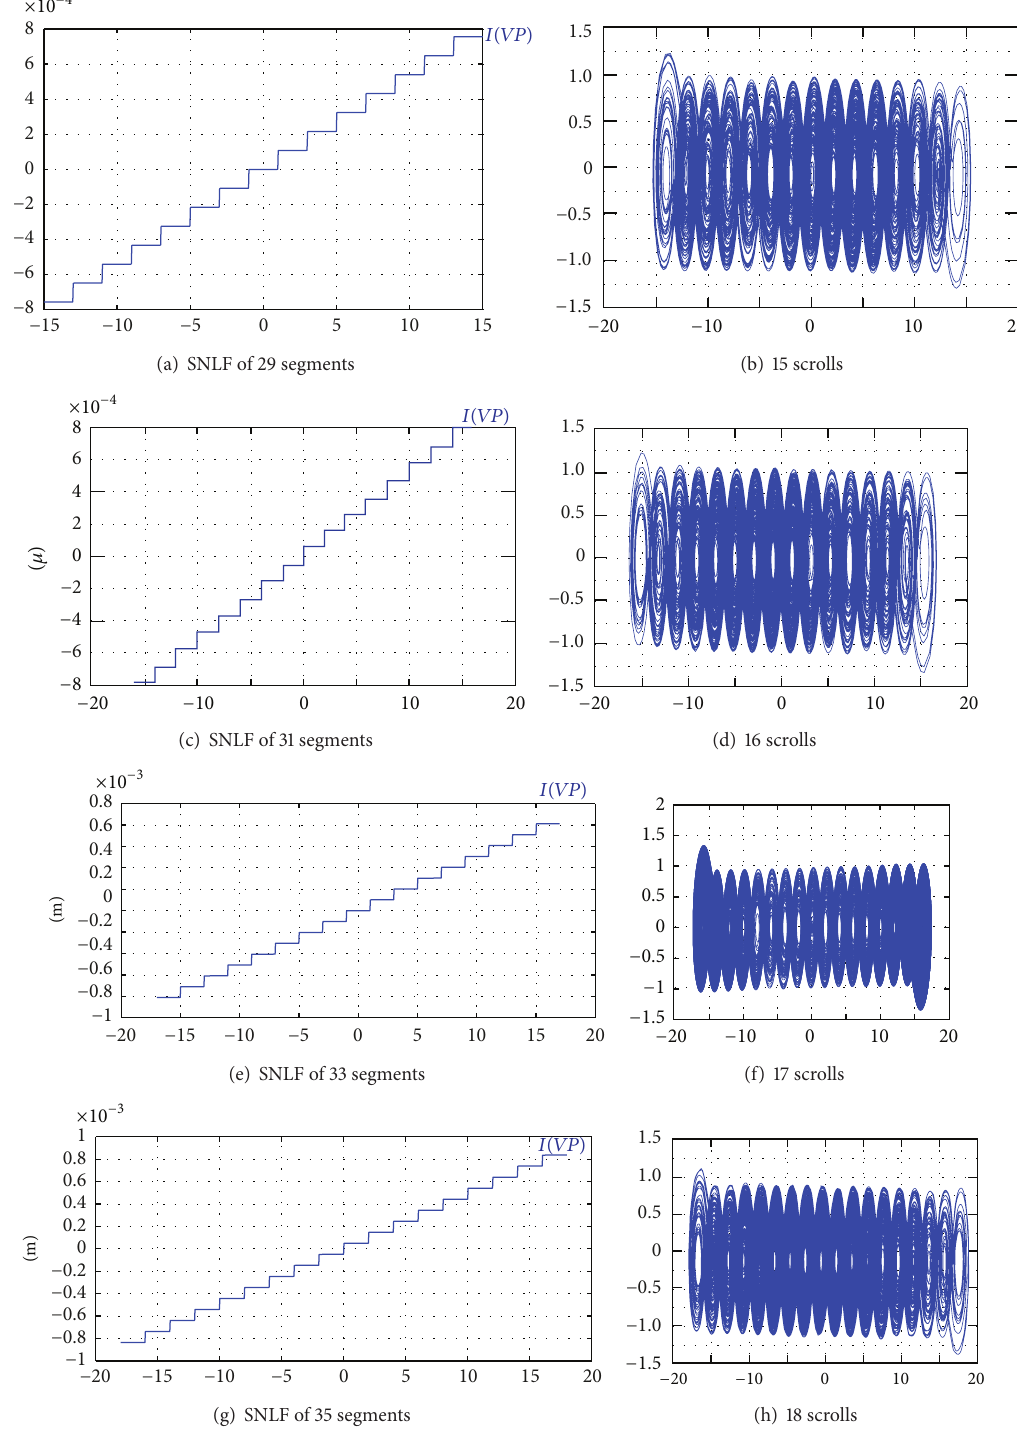
Figure 7: SNLF for generating 15 to 18 scrolls using